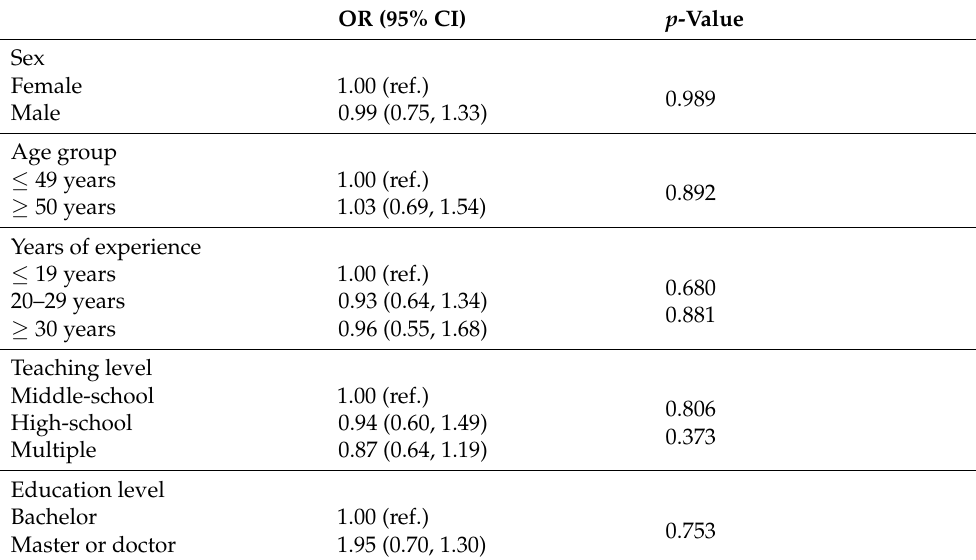
Table 3. Relation between the attitudes of teachers toward physical fitness tests by their